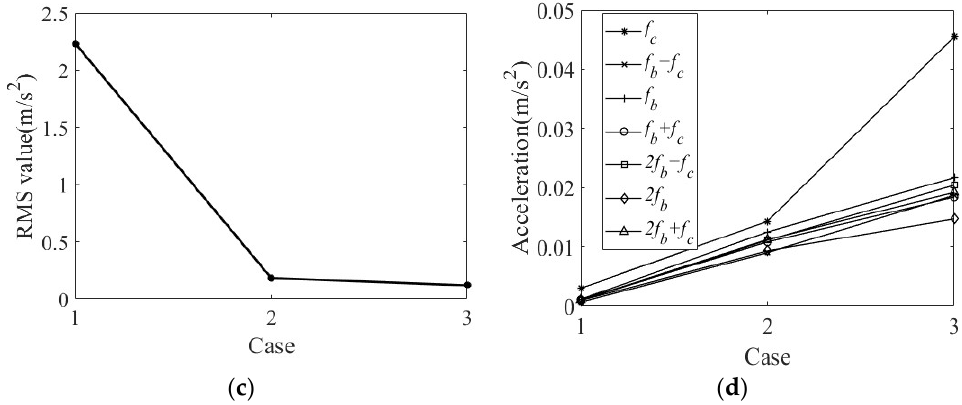
Figure 21. The time-domain and frequency responses of the bearing housing under roller defect and different housing stiffness: ( a ) acceleration signals; ( b ) envelope spectrum; ( c ) RMS; ( d ) amplitudes of f c , f b − f c , f b , f b + f c , 2 f b − f c , 2 f b , 2 f b + f c . As listed in Figure 22, the shock time of housing stiffness 2.24 × 10 6 N/m was earliest, followed by 1.5 × 10 7 N/m and 2.0 × 10 8 N/m. The above laws are relative to the contact forces. Compared with other defects, the defective roller rotated for 2π, and came into contact with the outer ring and inner ring successively. Then, two shocks in a relatively the housing acceleration.